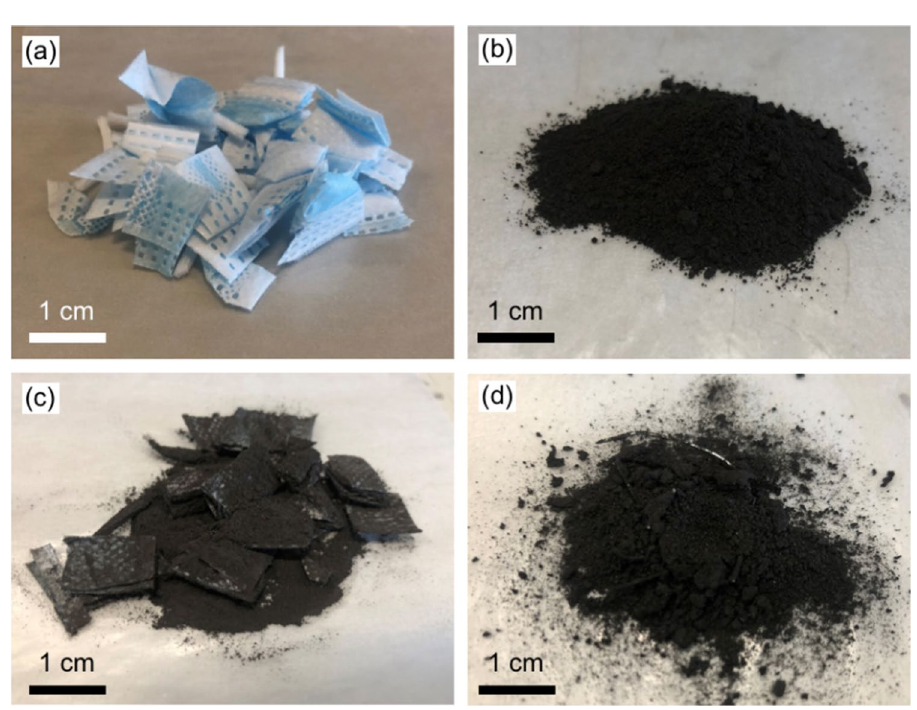
Figure 2. Materials at various stages of the milling process. ( a ) Coarsely cut untreated facemasks, ( b ) GCI coal, ( c ) cut facemasks and GCI coal before heat treatment and ( d ) facemasks and GCI coal after 1 h at 250 °C and before milling showing the